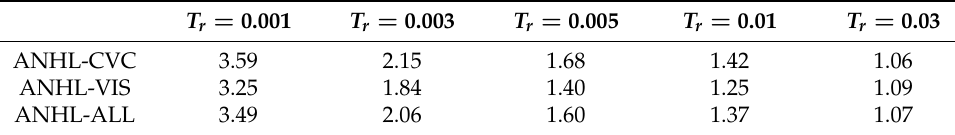
Table 1. Average number of homography layers (ANHL) with different T r . T r = 0.001 T r = 0.003 T r = 0.005 T r =